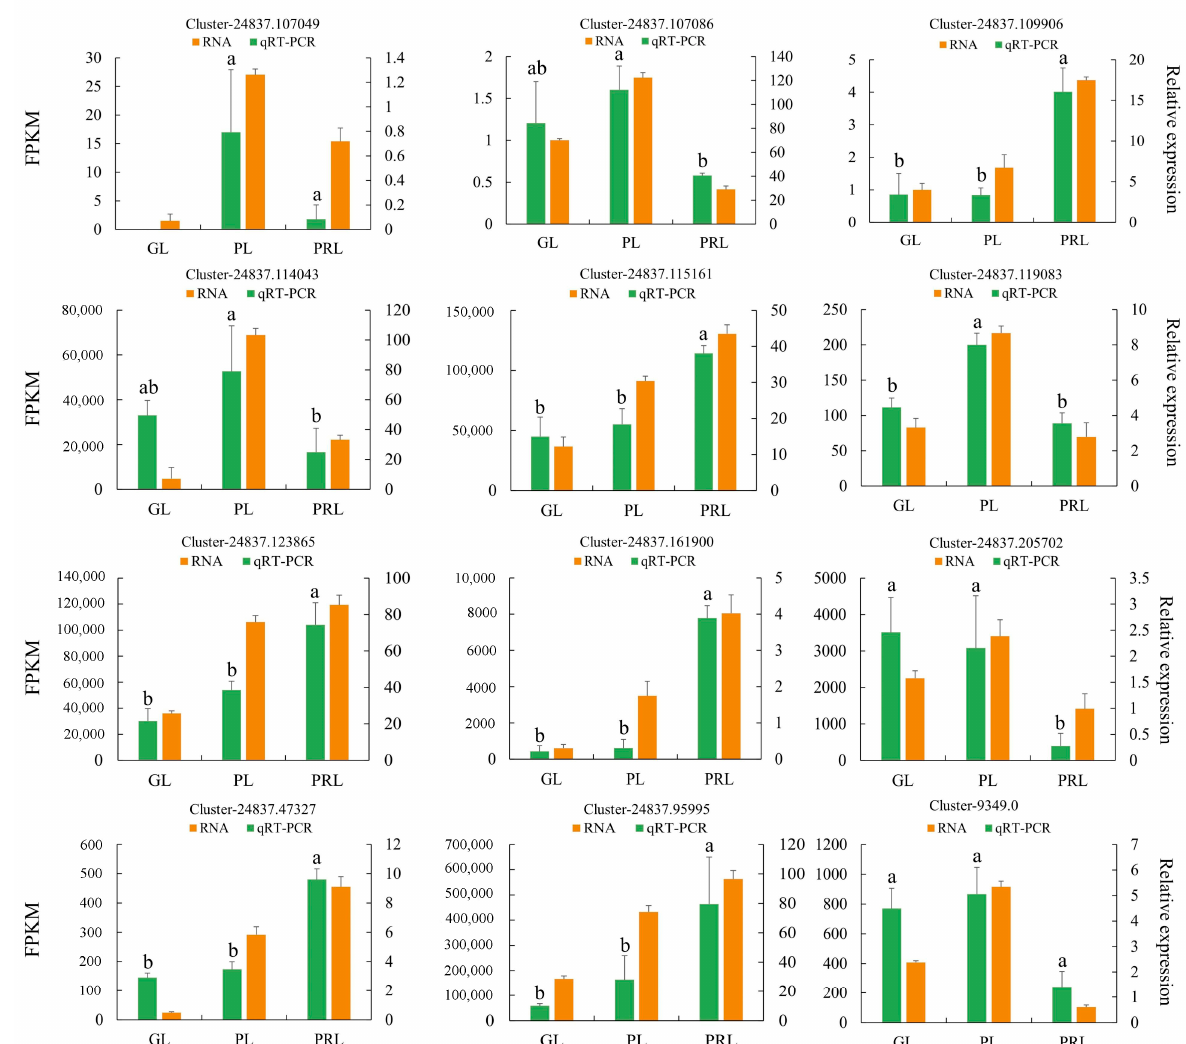
Figure 9. Quantitative real-time PCR verification of expression levels of 12 DEGs identified by RNA sequencing. The y -axis on the left represents the FPKM value obtained by RNA-seq. The y -axis on the right shows the relative gene expression levels (2 − ∆∆ C t ) analyzed by qRT-PCR. The x -axis represents the different leaves samples. Bars with different lowercase letters are significantly different ( p < 0.05). GL, green leaves; PL, purple leaves; PRL, purple-red leaves. FPKM represents fragments per kilobase per million.